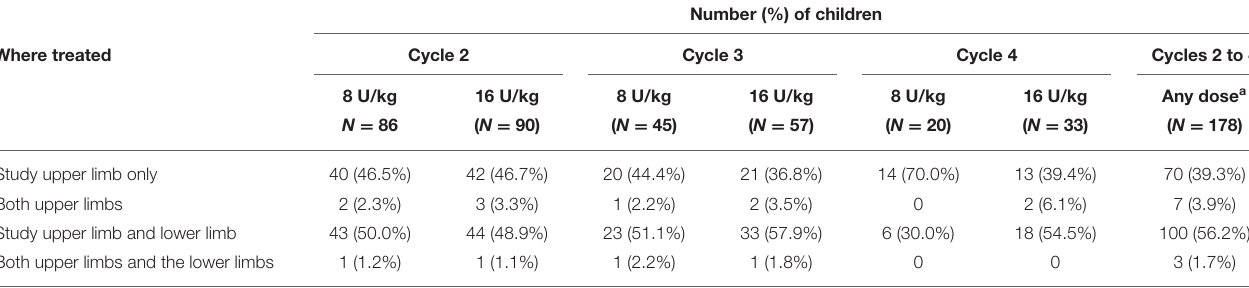
TABLE 3 | Proportion of children receiving injections into other (non-study)